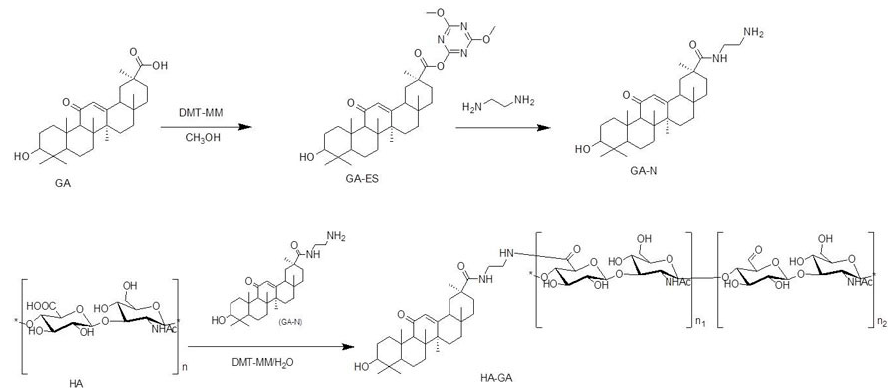
Figure 1. Synthetic route of hyaluronic acid-glycyrrhetinic acid (HA–GA) conjugate via 4-(4,6- dimethoxy-1,3,5-triazin-2-yl)-4-methylmorpholinium chloride (DMT–MM)-mediated coupling reactions.